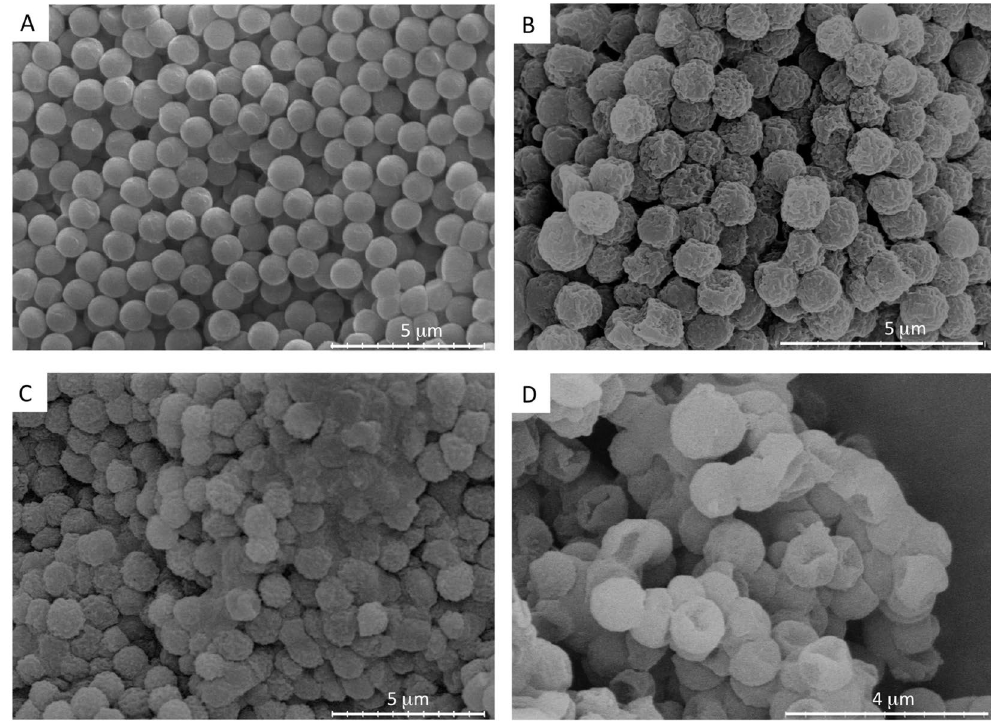
Figure 1. SEM images of hollow spheres. ( A ) 1 μ m polystyrene templates, ( B ) mixed collagen-PPS hollow spheres, ( C ) mixed collagen-dithiolPEG hollow spheres (control), ( D ) mixed collagen-4armPEG hollow spheres